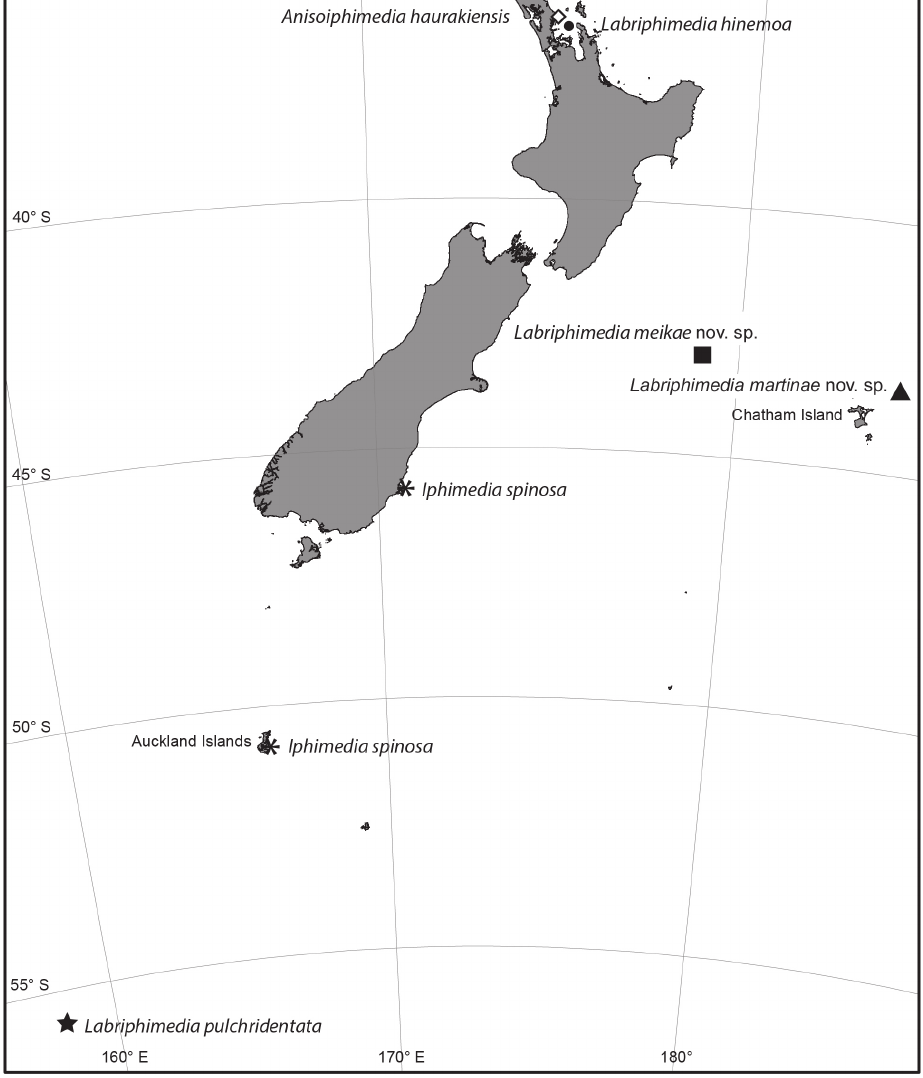
Fig. 1. Iphimediidae recorded from new zealand, from subtropical to subantarctic